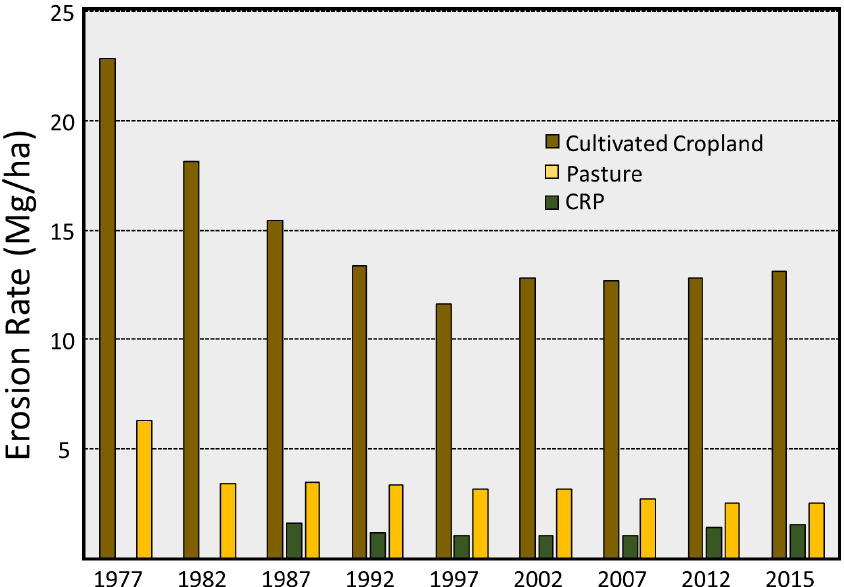
Figure 2. Estimated average annual sheet and rill erosion by water for the state of Iowa, according the USDA National Resources Inventory [56].